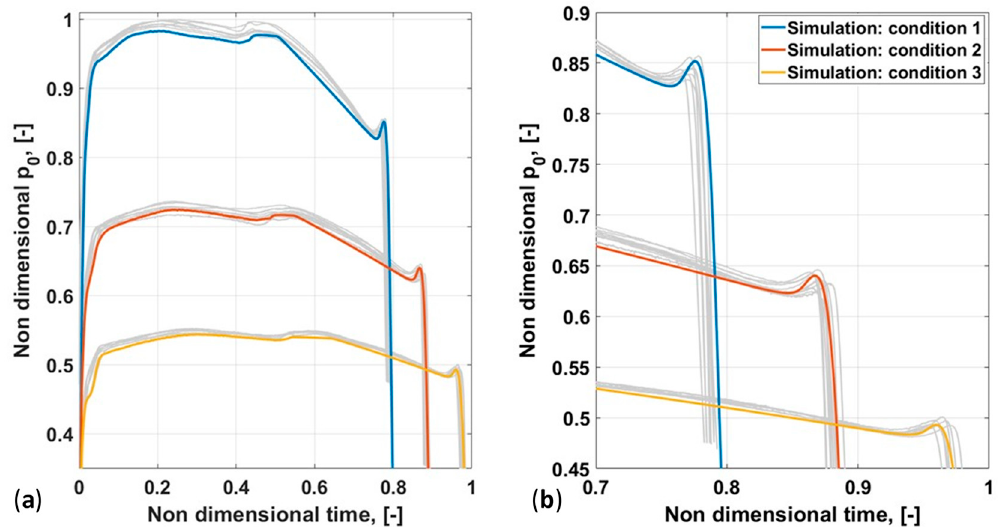
Figure 17. Comparison between simulated and experimental combustion chamber pressure profiles: ( a ) nondimensional chamber pressure as a function of nondimensional time; ( b ) zoom of the nondimensional chamber pressure in the tail-off region.